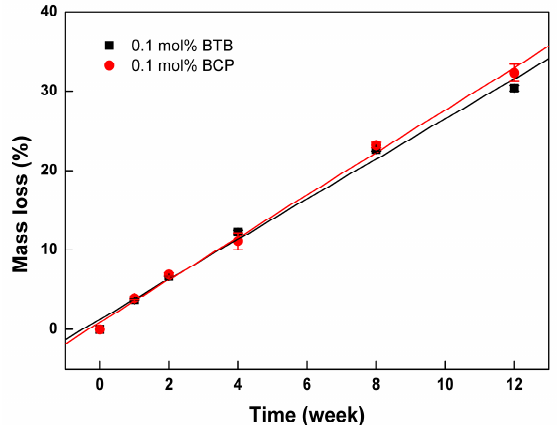
Figure 4. The mass loss of BTB and BCP cross-linked PTMC 256 -0.1 during in vitro enzymatic degradation as a function of time.